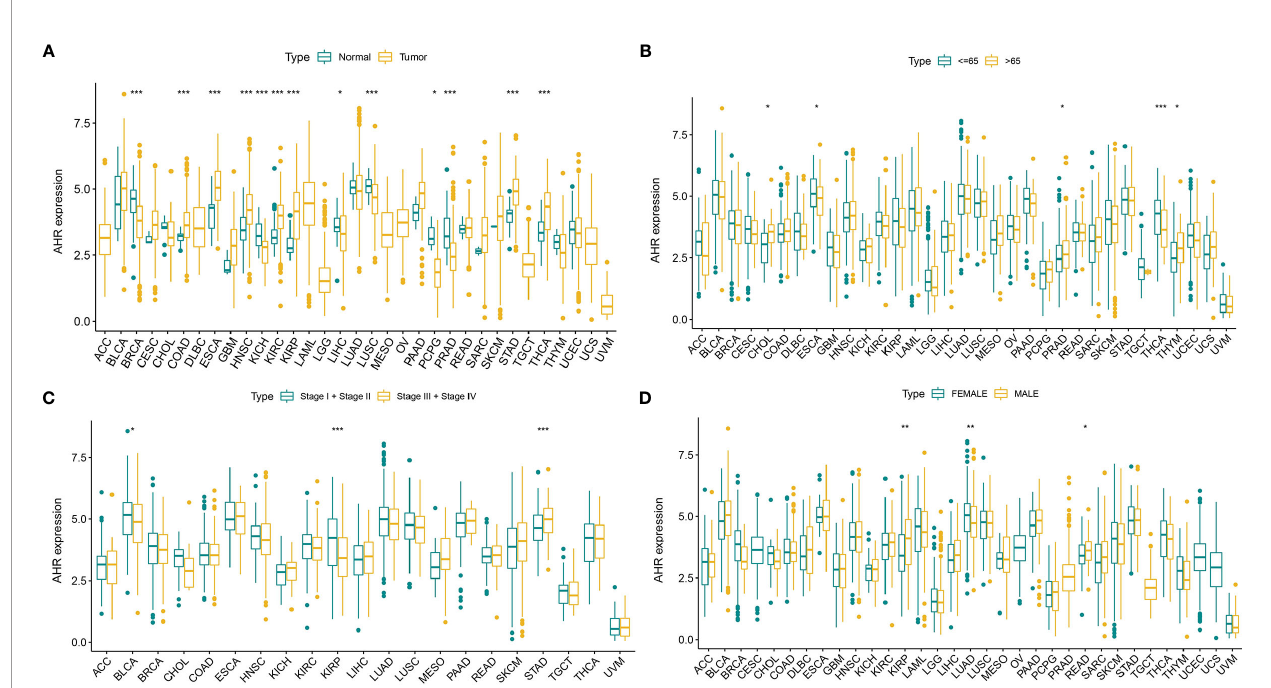
FIGURE 2 | The clinical correlation of AhR. (A) shows the differential expression analysis between tumor and normal groups of AhR in 33 cancers; (B) represents the correlation between age and AhR; (C) demonstrates the correlation between tumor stage and AhR; (D) shows the correlation between gender and AhR. “ * ” indicates p < 0.05, “ ** ” indicates p < 0.01 and “ *** ” indicates p <